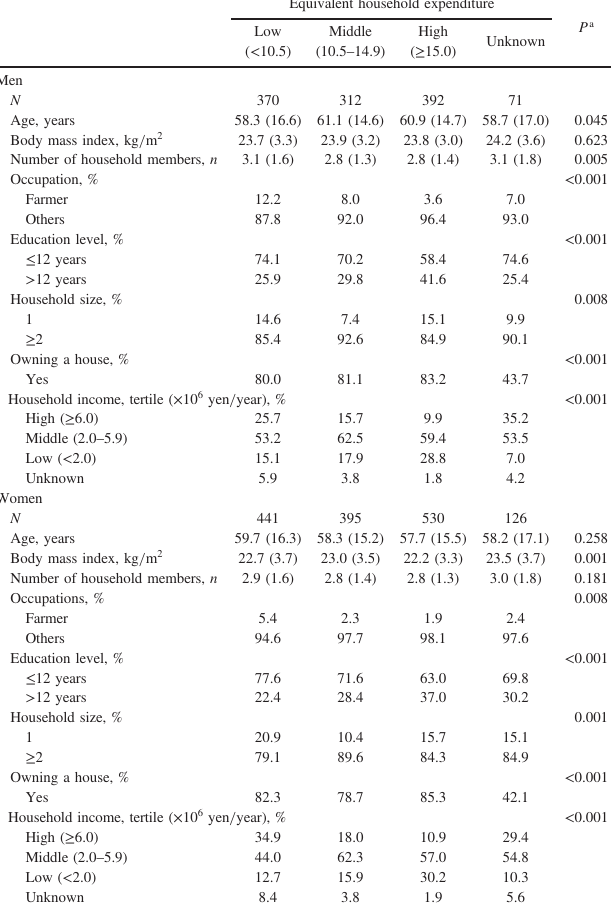
Table 2. Characteristics of study participants according to the equivalent household expenditure: NIPPON DATA2010